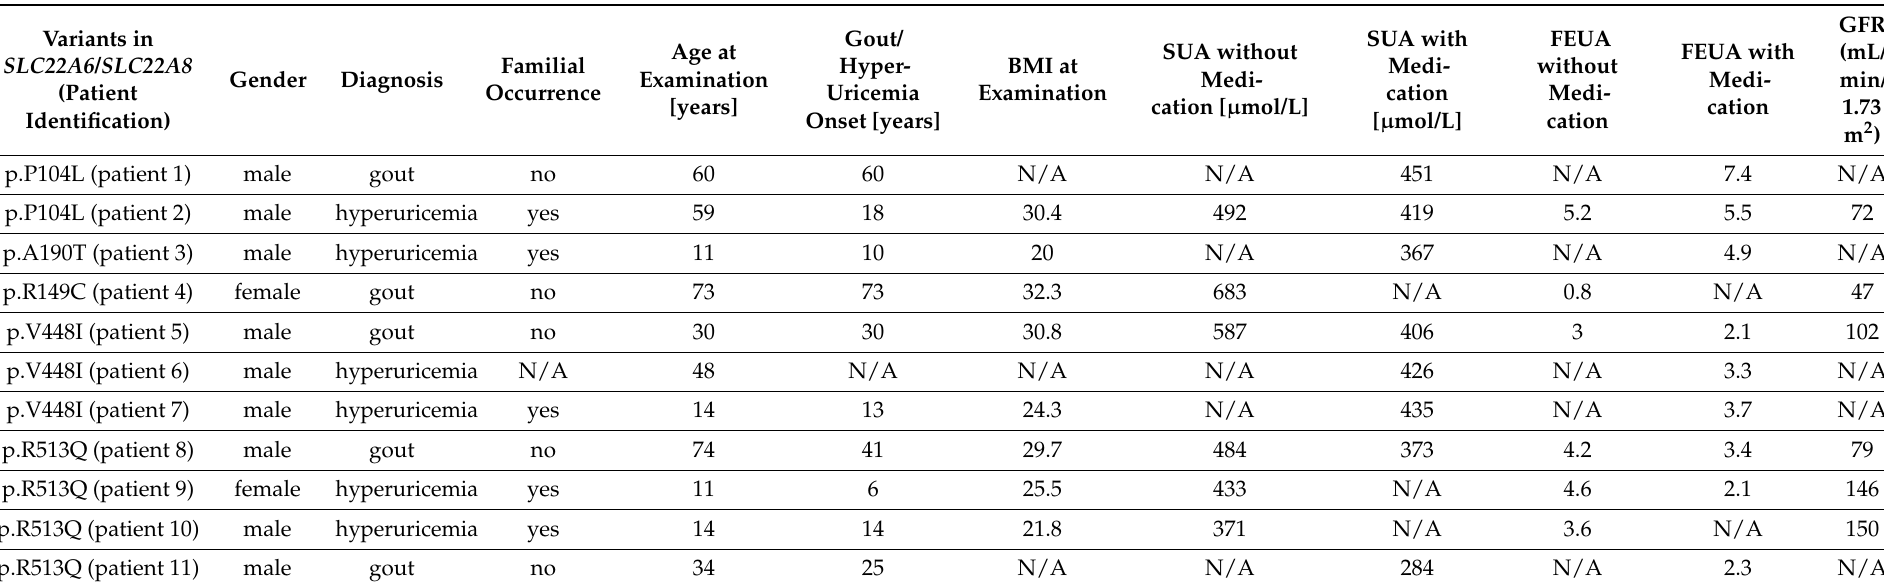
Table 4. Main demographic and biochemical characteristics of patients with non-synonymous variants in the SLC22A6 and SLC22A8 genes. GFR was estimated via the CKD-EPI